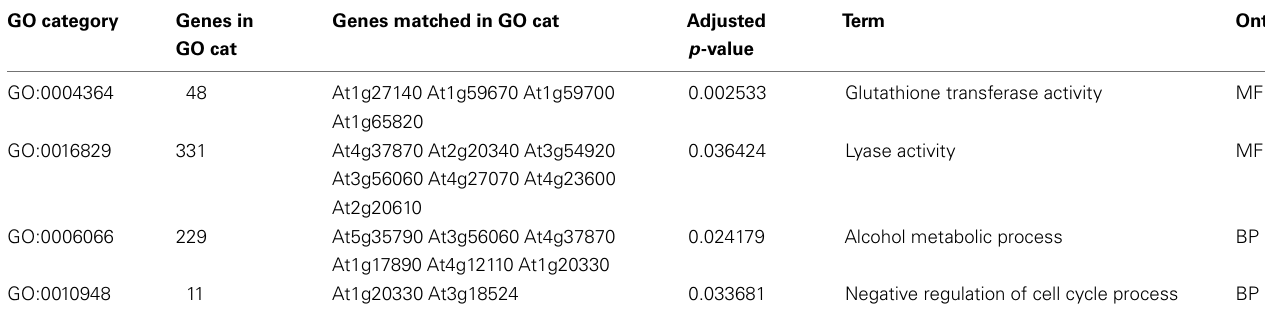
Table 3 | Overrepresented GO categories in lists of genes with overlapping eQTLs in both GG2 and GG1 with opposite additive